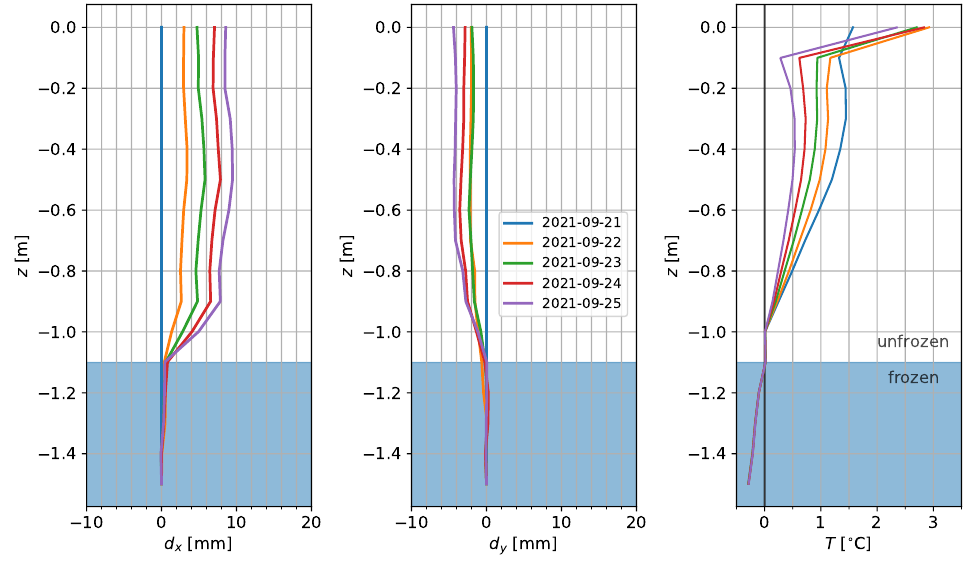
Figure 14. Field measurements obtained over five days at a field site on the Seward Peninsula, AK which is experiencing soil movements in response to permafrost thaw. Left and middle panels show the displacement along the x and y -axis, respectively; right column shows the soil temperature. Highlighted in blue is the frozen part of the subsurface, showing that the slip plane is colocated with the interface between frozen and unfrozen